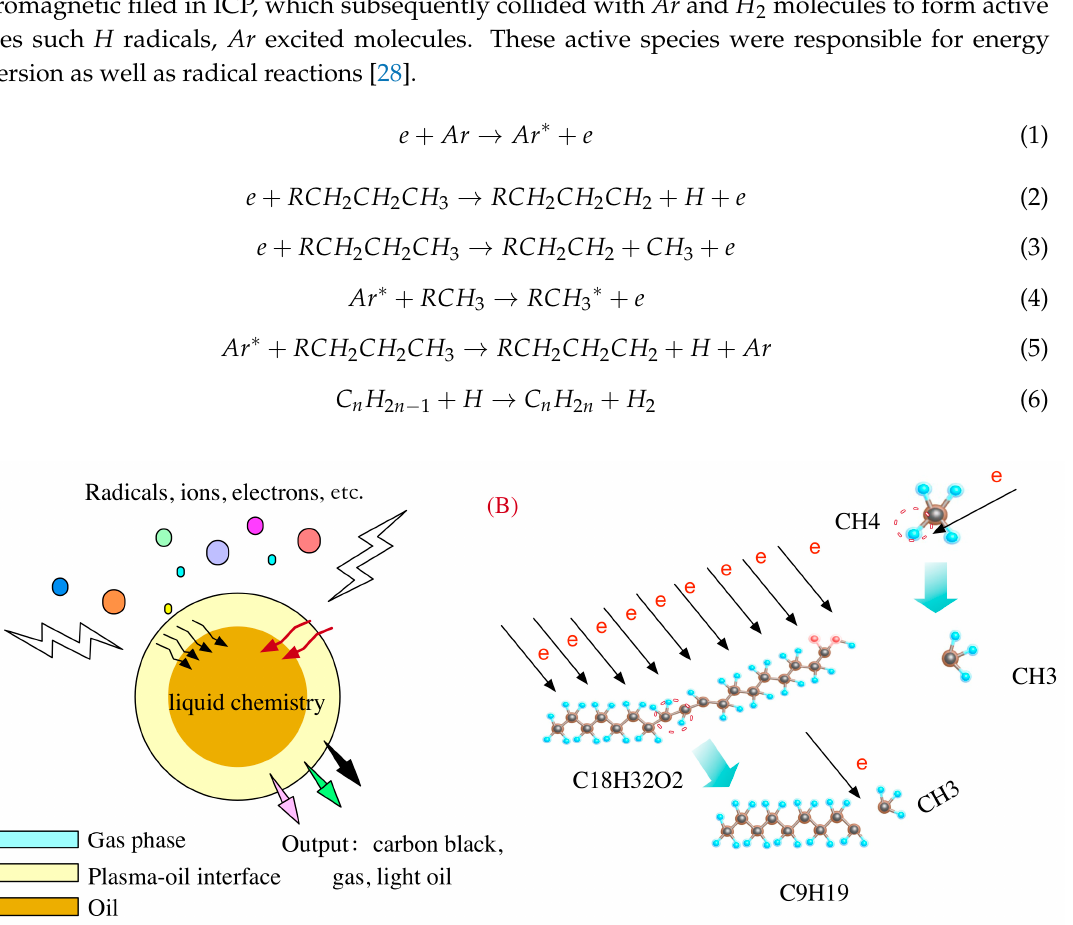
Figure 5. ( A ) Decomposition of waste lard oil in PECVD and the effect of electron collisions; ( B ) Breakdown of fatty acid chains induced by electron collisions.